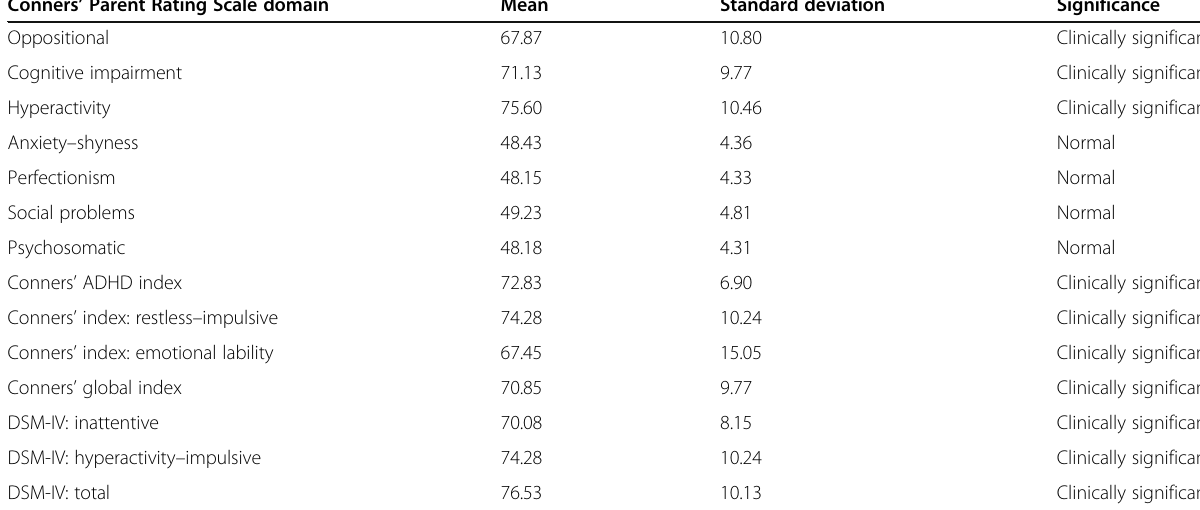
Table 2 Severity of ADHD in the patient group as assessed by Conners ’ Parent Rating Scale